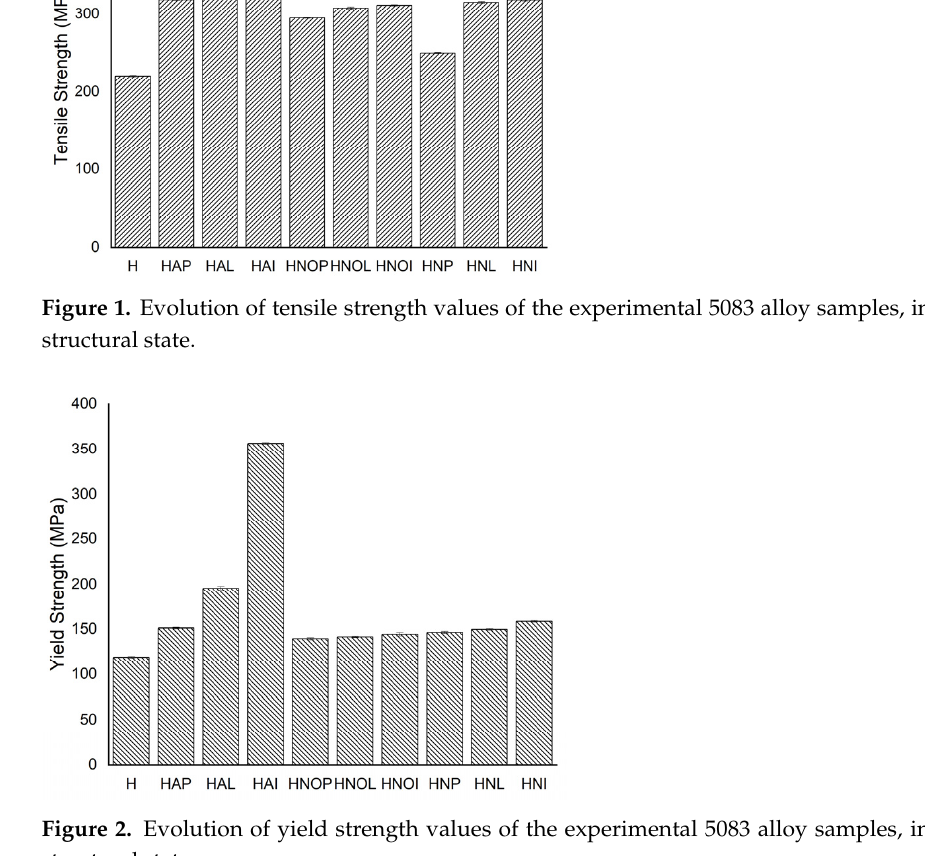
Figure 4. Evolution of hardness values of the experimental 5083 alloy samples, in different structural states . Figure 5. Evolution of resilience strength values of the experimental 5083 alloy samples, in different structural states. 3.2. Results Concerning Structural Characterization of the Experimental Samples Results concerning the structural analysis of the experimental samples concerning metallographic aspects after applications of different heat treatments of the cast aluminum 5083 samples are given in Figure 6. One may remark that at the gauge sample there is a dendritic aspect of the sample (Figure 6a), with small amounts of particles, precipitated in a dendritic manner. By applying quenching and aging, it takes place the homogenization of the matrix, the particles being still in dendritic separation (Figure 6b–j). Additionally, one may remark that in gauge samples there are the biggest gains, in a nonhomogeneous